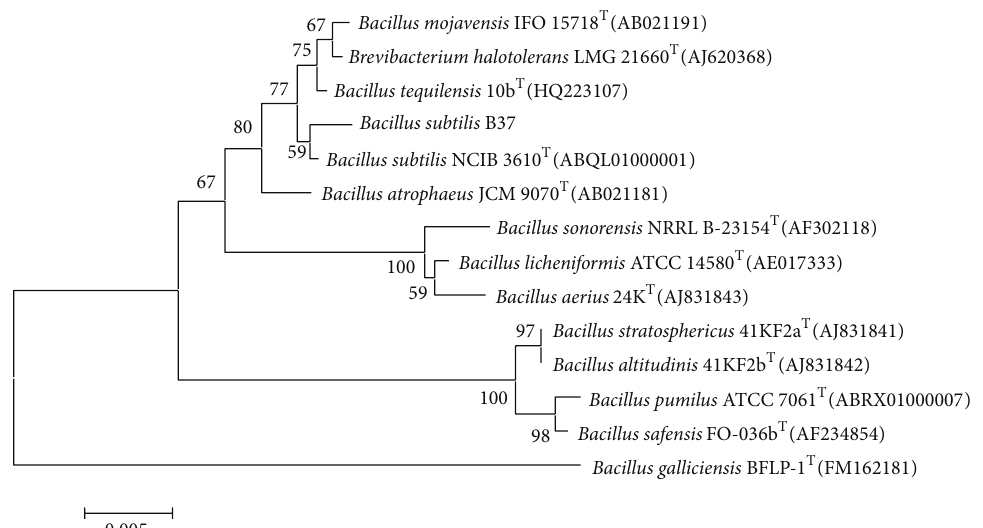
Figure 4: A neighbor-joining phylogenetic dendrogram based on 16S rRNA gene sequences showing the position of strain B37 among members of the genus Bacillus species. Numbers on branch nodes are percentage bootstrap values (100 resamplings). The “T” in the figure means “type